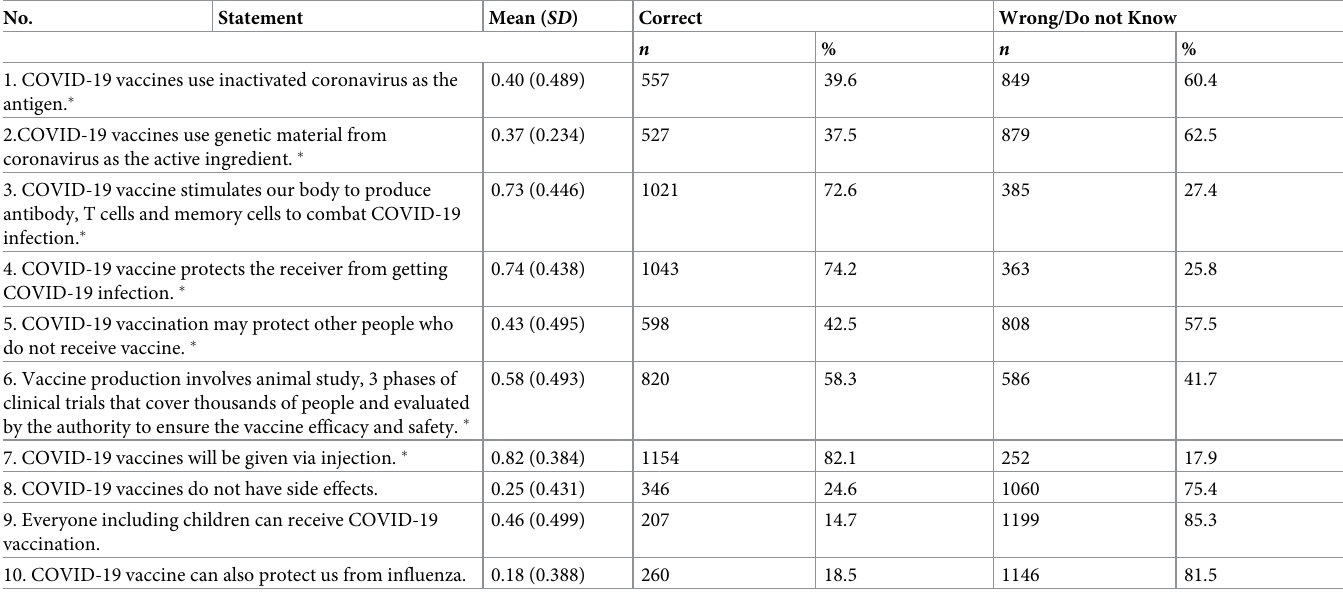
Table 2. Knowledge about COVID-19 vaccine (N =